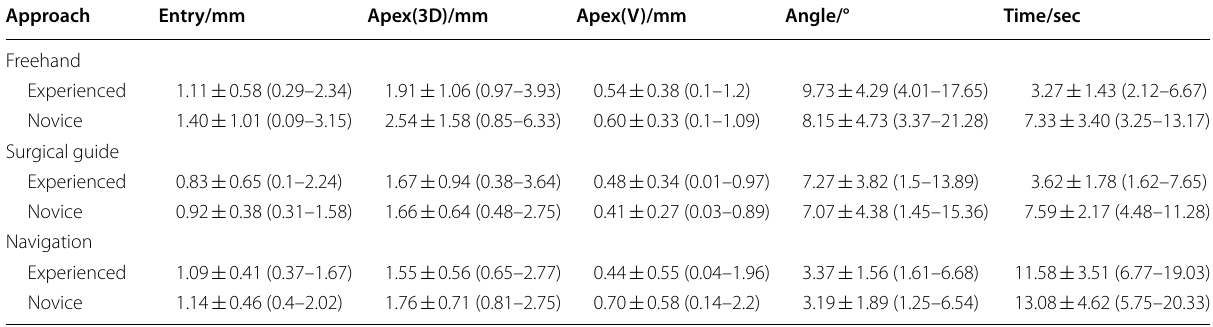
SD, Range) categorized by surgical approach and experience ±